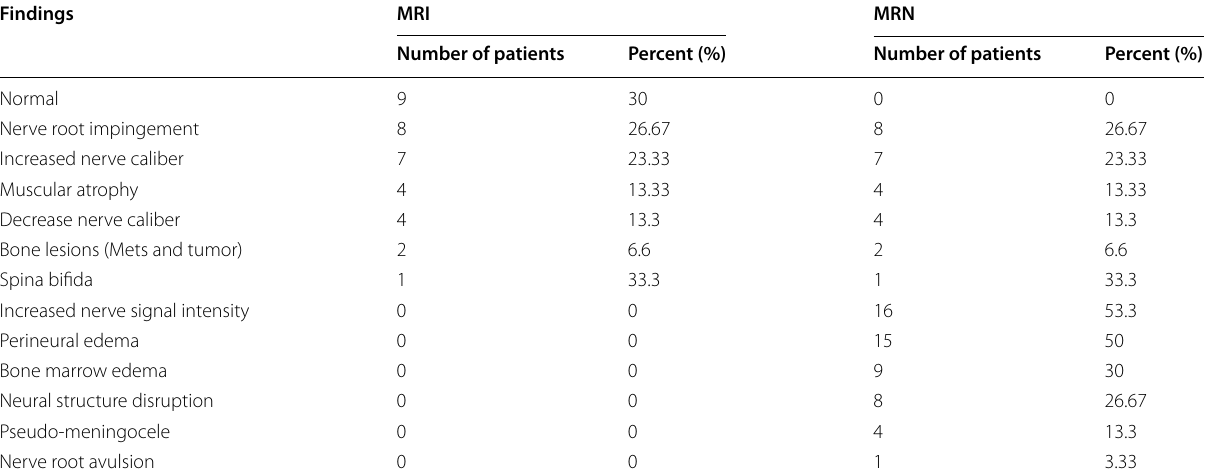
Table 4 Comparison between conventional MRI and MRN findings Findings